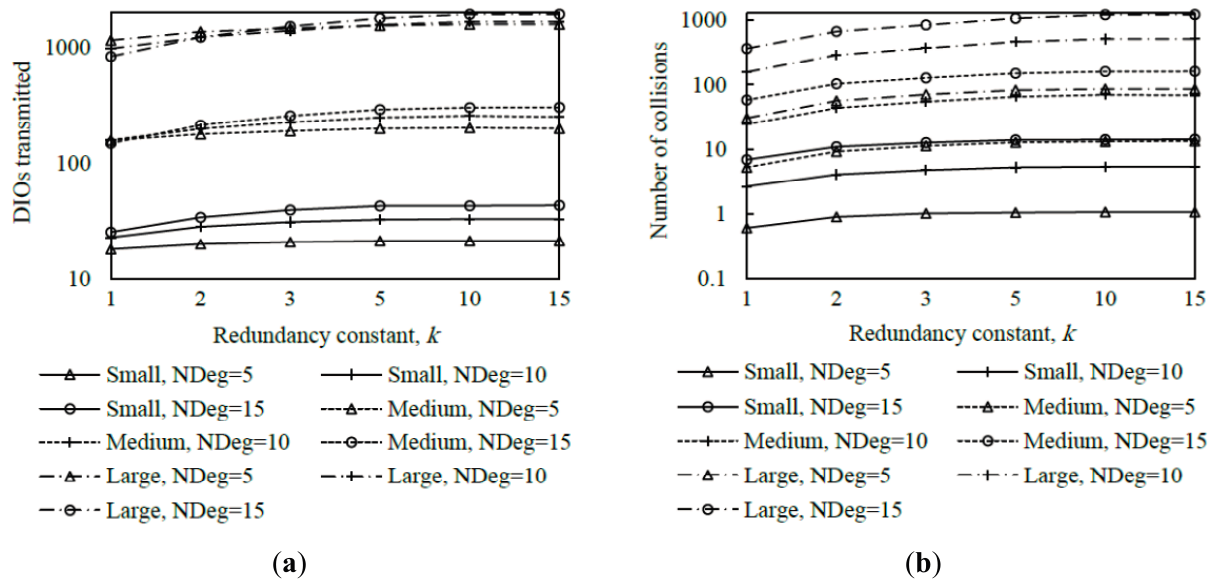
Figure 9. Average number of DIO messages transmitted ( a ) and collisions ( b ) in three network size scenarios, for different network densities, as a function of the redundancy constant, k . NDeg denotes the average node